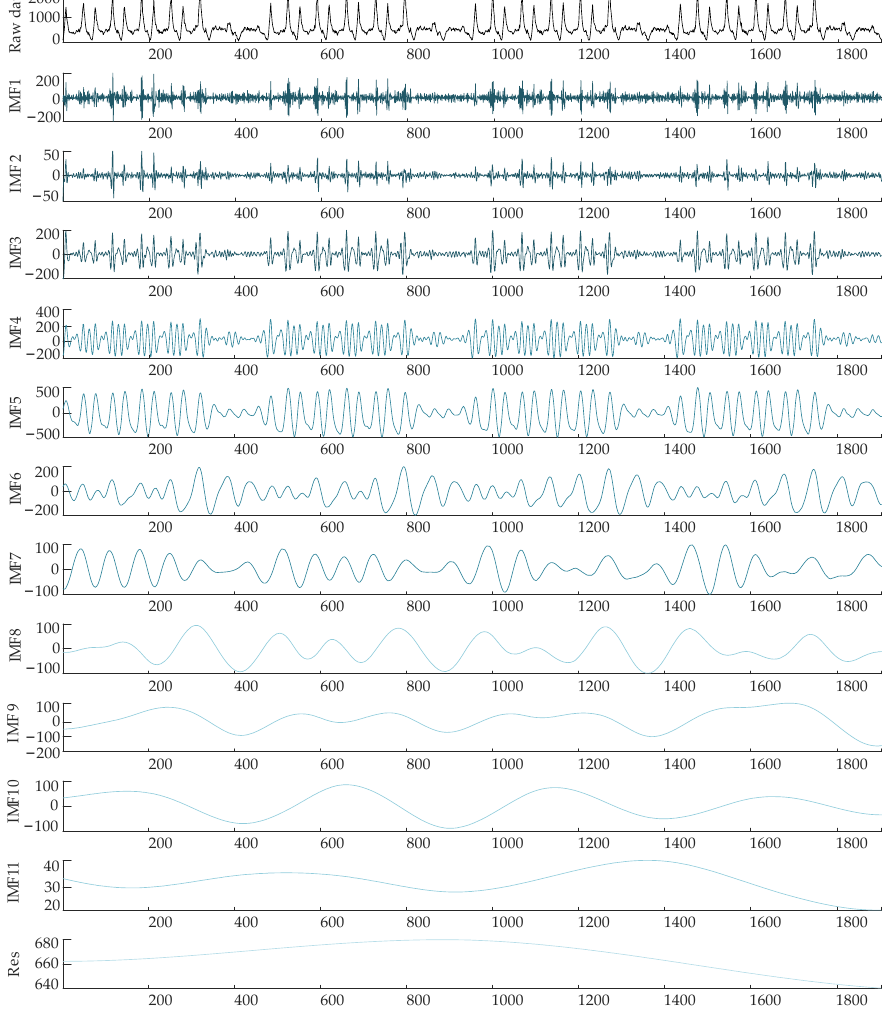
Figure 4. IMFs and Res obtained from the daily inbound passenger flow data after CEEMDAN de ‐ composition.